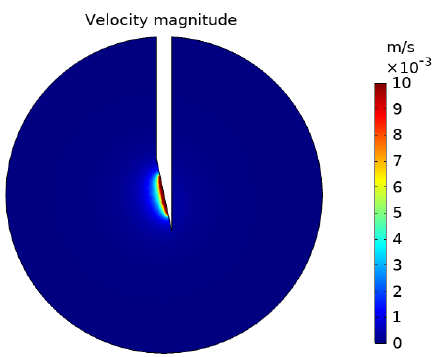
Figure 4. Fluid velocity magnitude contours at a cut plane through the tumour.